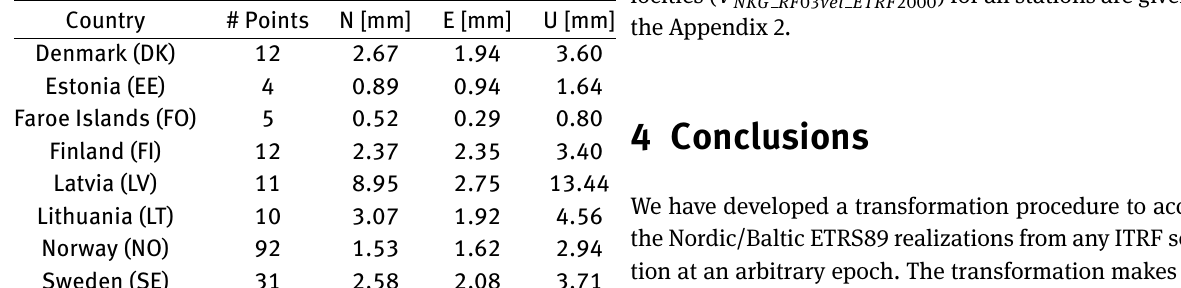
Table 7: Rms of transformation residuals for Nordic-Baltic countries. Country #